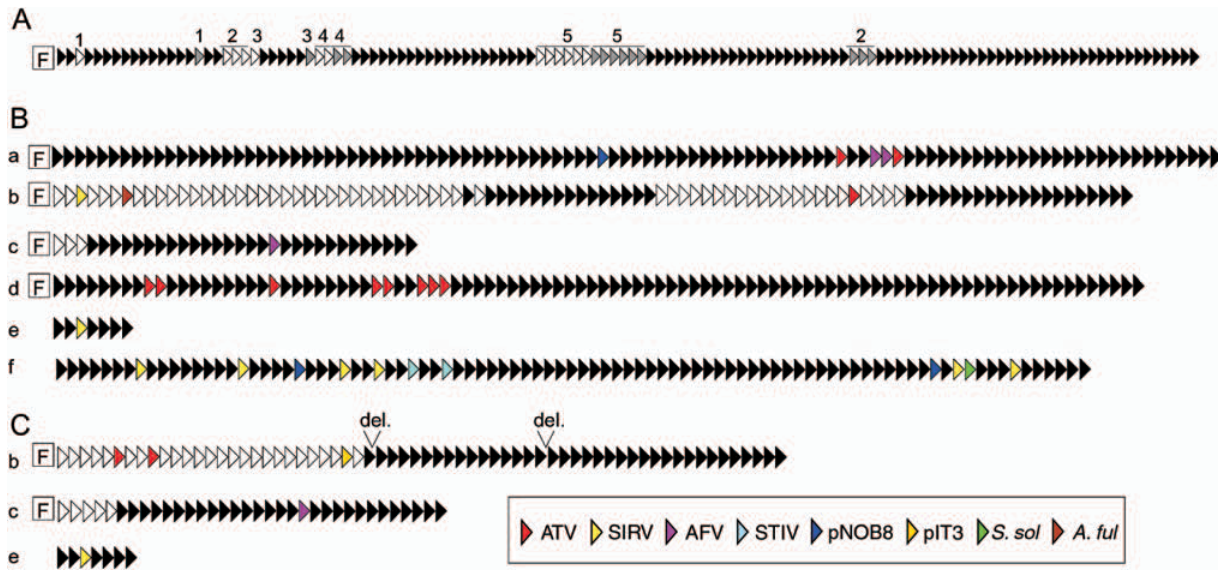
Figure 1. (A) A map of mthe-124from M. thermoautotrophicus showing the locationsof duplicatedspacer-repeat units, or groups of units, labeled 1–5. Each triangle represents a spacer-repeat unit. Duplicated spacer-repeat units are shaded in gray. (B) Schematic representation of the six clus- ters which occur in the genome of S. solfataricus P2B (She et al. 2001). Each triangle represents a spacer-repeat unit. The colored triangles are coded to indicate the archaeal viruses, plasmids or chromosomes ( S. solfataricus or A. fulgidus ) that yield good matches with the spacer sequence. (C) A correspondingscheme is presentedfor three of the six clusters(ssol-95,ssol-32and ssol-7)thatare presentin the chromosomeof the closely related strain S. solfataricus P1 (Accession numbers: DQ831675, DQ831676 and DQ831677). Open triangles denote those spacer-repeat units that differ in sequence between the strains P1 and P2A. Abbreviation: del. indicates the two sites where deletion of several spacer-repeat units has occurred in strain P1 (or where insertions have occurred in strain P2B).